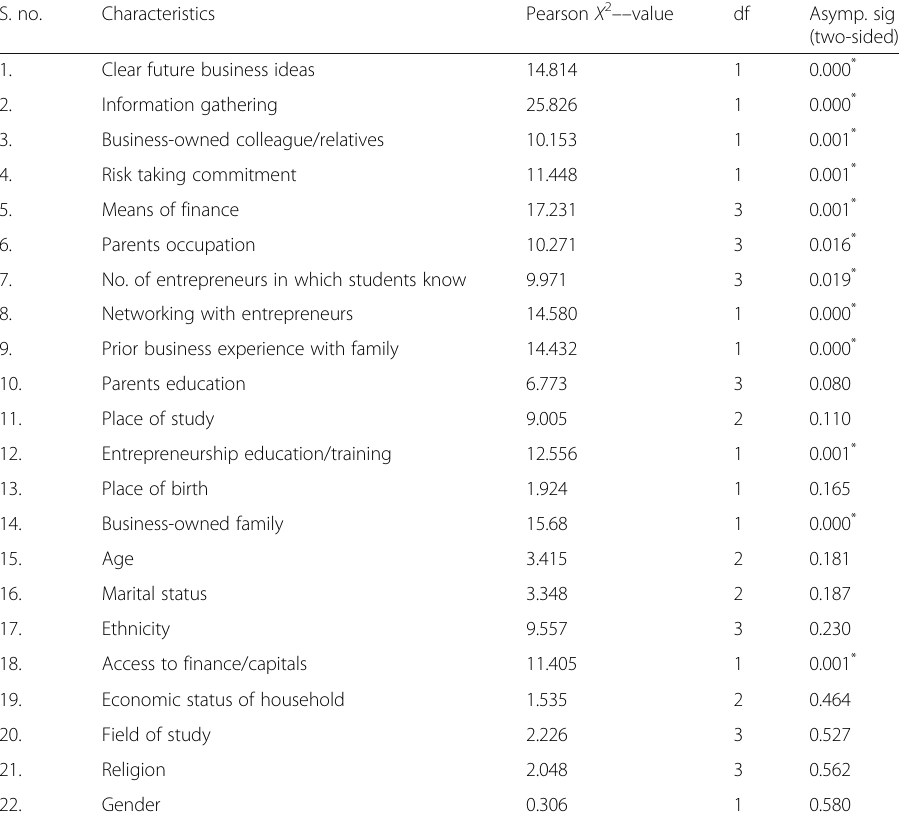
Table 5 Test of association B / n self-employment intention with demographic and socio-economic characteristics of